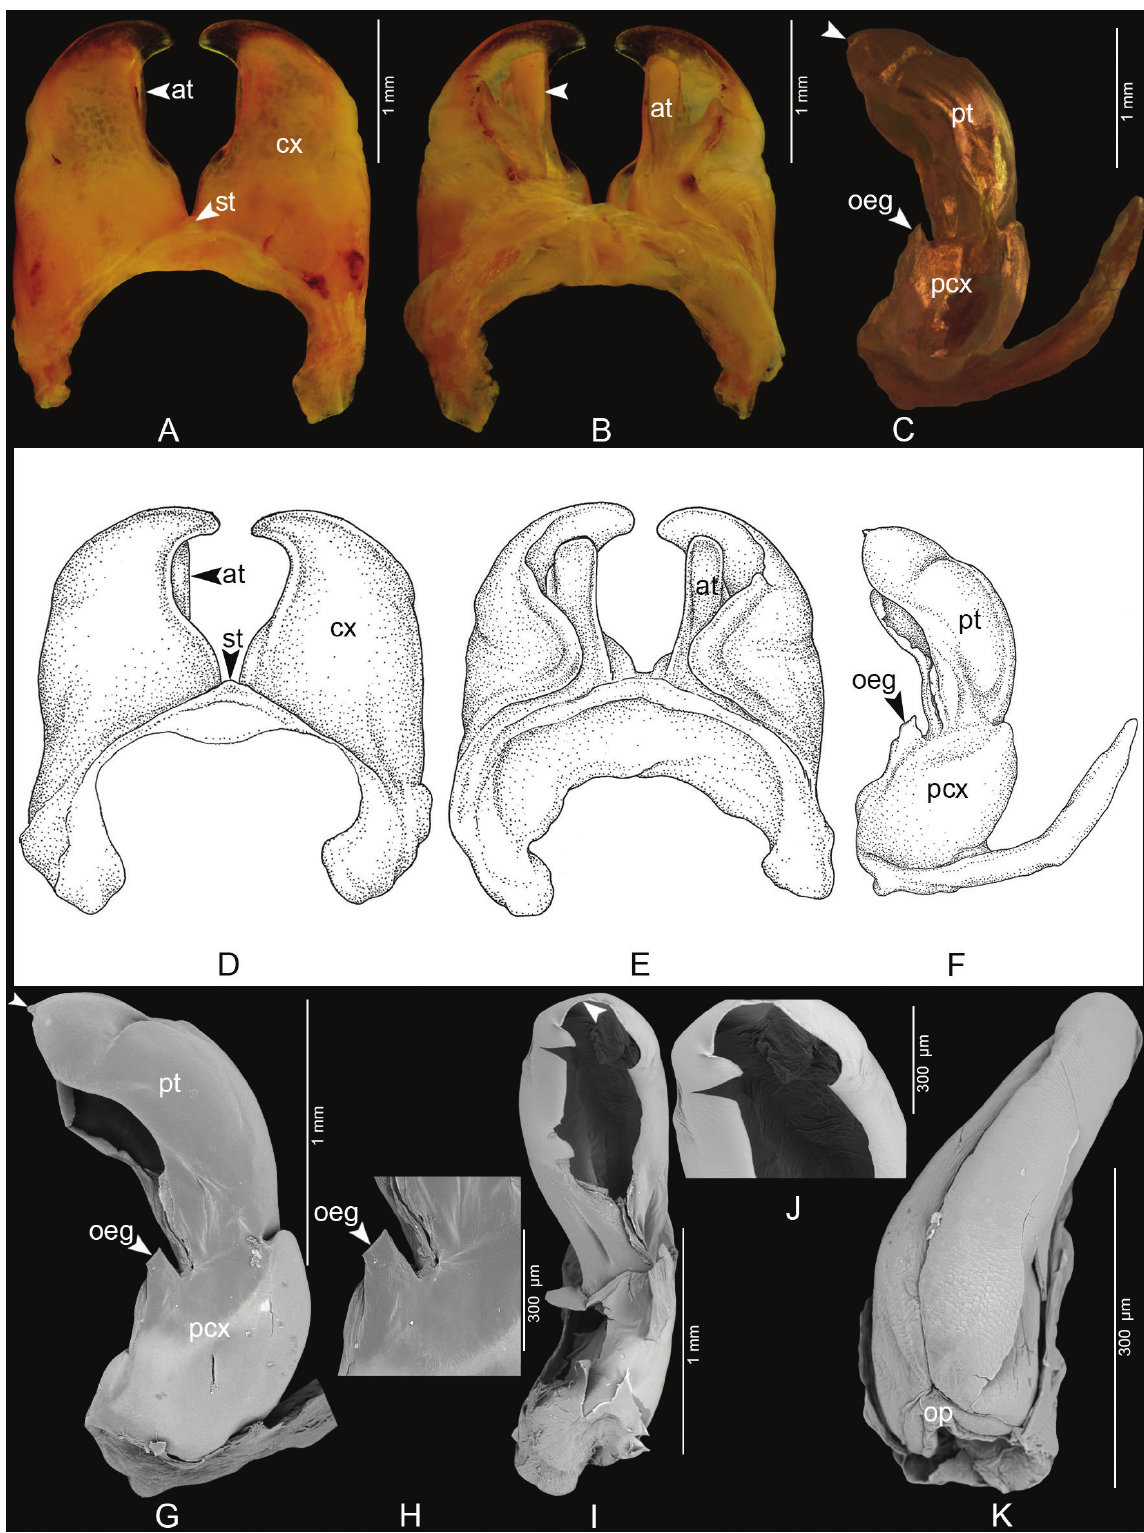
Figure 5. Siliquobolellus prasankokae gen. et sp. nov., holotype, gonopods (specimen from Pha Thai, CUMZ-D00148-1). A. An- terior gonopod, anterior view; B. Anterior gonopod, posterior view, arrow indicates a a thumb-like process with strong ridge di- stomesally; C. Right posterior gonopod, lateral view, arrow indicates a short, sharp protrusion; D. Anterior gonopod, anterior view; E. Anterior gonopod, posterior view; F. Right posterior gonopod, lateral view; G. SEM, Right posterior gonopod, lateral view, arrow indicates a short, sharp protrusion; H. SEM, Mesal part of right posterior gonopod, lateral view; I. SEM, Right posterior gonopod, mesal view, arrow indicates a canopy; J. SEM, Tip of right posterior gonopod, mesal view; K. SEM, left female vulva, posterior mesal view. at = anterior gonopod telopodite; cx = coxa; oeg = opening of efferent groove; op = operculum of vulva; pcx = coxal part of the posterior gonopod telopodite; pt = telopodital part of the posterior gonopod telopodite; st = sternal